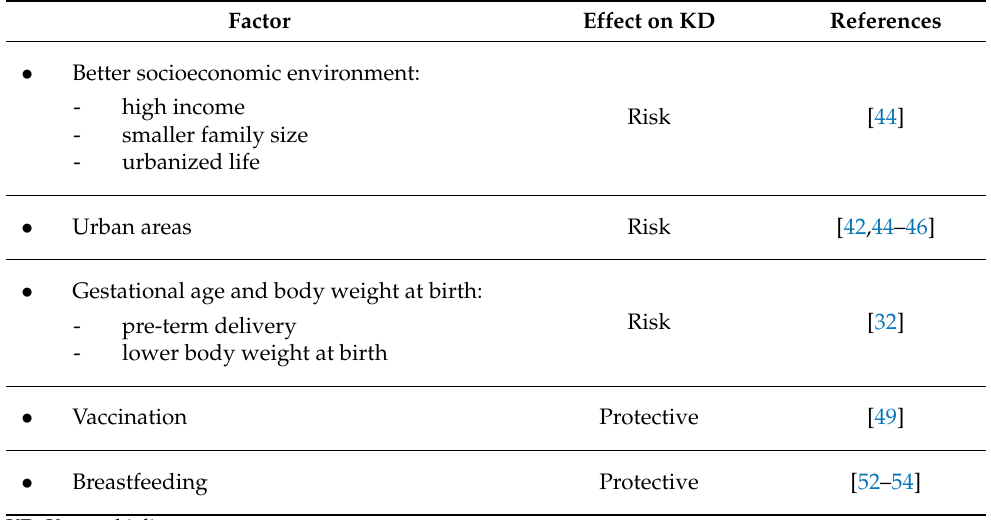
Table 2. Epidemiological risk factors for Kawasaki disease (KD). Factor Effect on